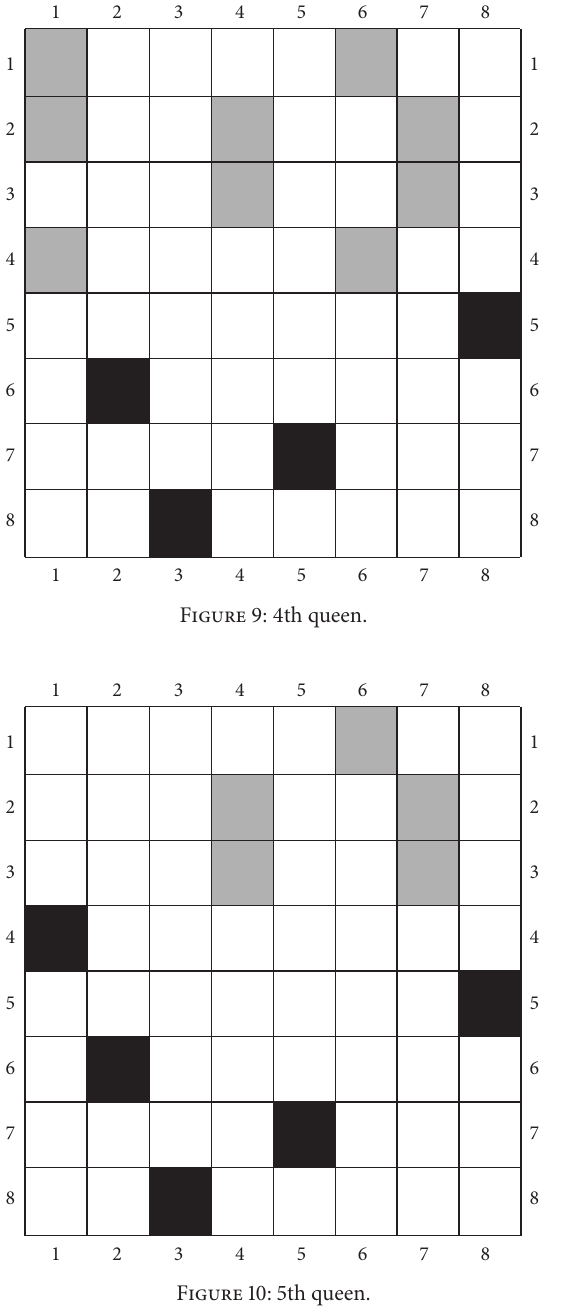
Figure 10: 5th queen.